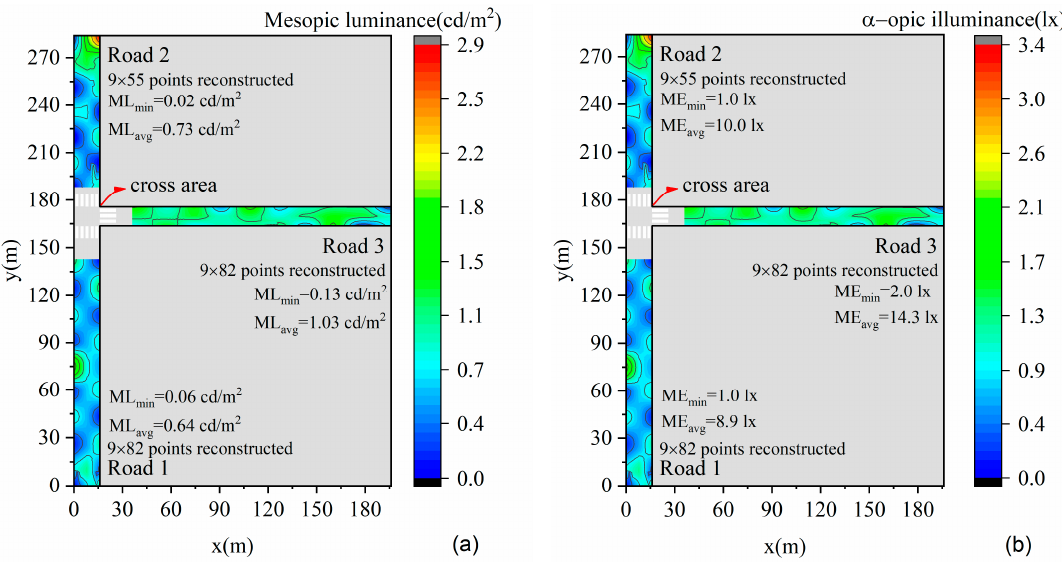
Figure 15. Lighting performance evaluation. ( a ) Mesopic luminance calculation based on reconstructed illuminance; ( b ) equivalent melanopic lux calculation based on reconstructed illuminance. ML represents mesopic luminance, and ME represents equivalent melanopic lux.